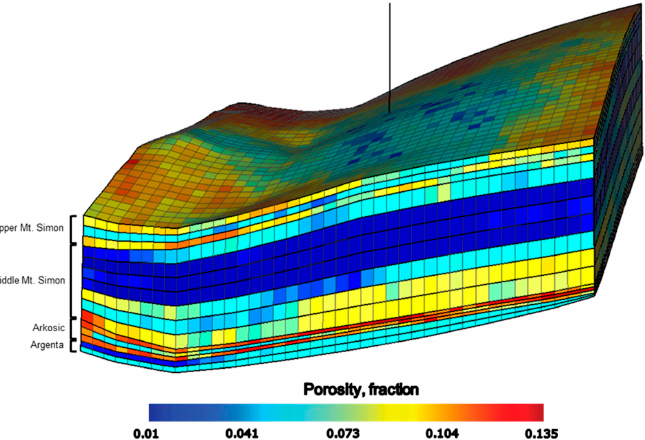
Figure 2. Block diagram illustrating the porosity of the reservoir. The model’s size is approximately 35 km × 35 km × 550 m (x, y, z).